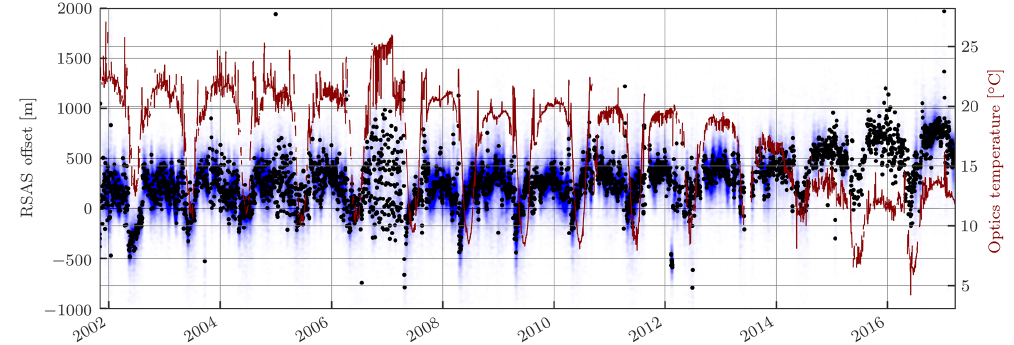
Figure 2. Calculated RSAS tangent height offset for every OSIRIS scan (transparent blue dots) and daily averages (black dots). The daily average OSIRIS optics box temperature is shown as the red line.